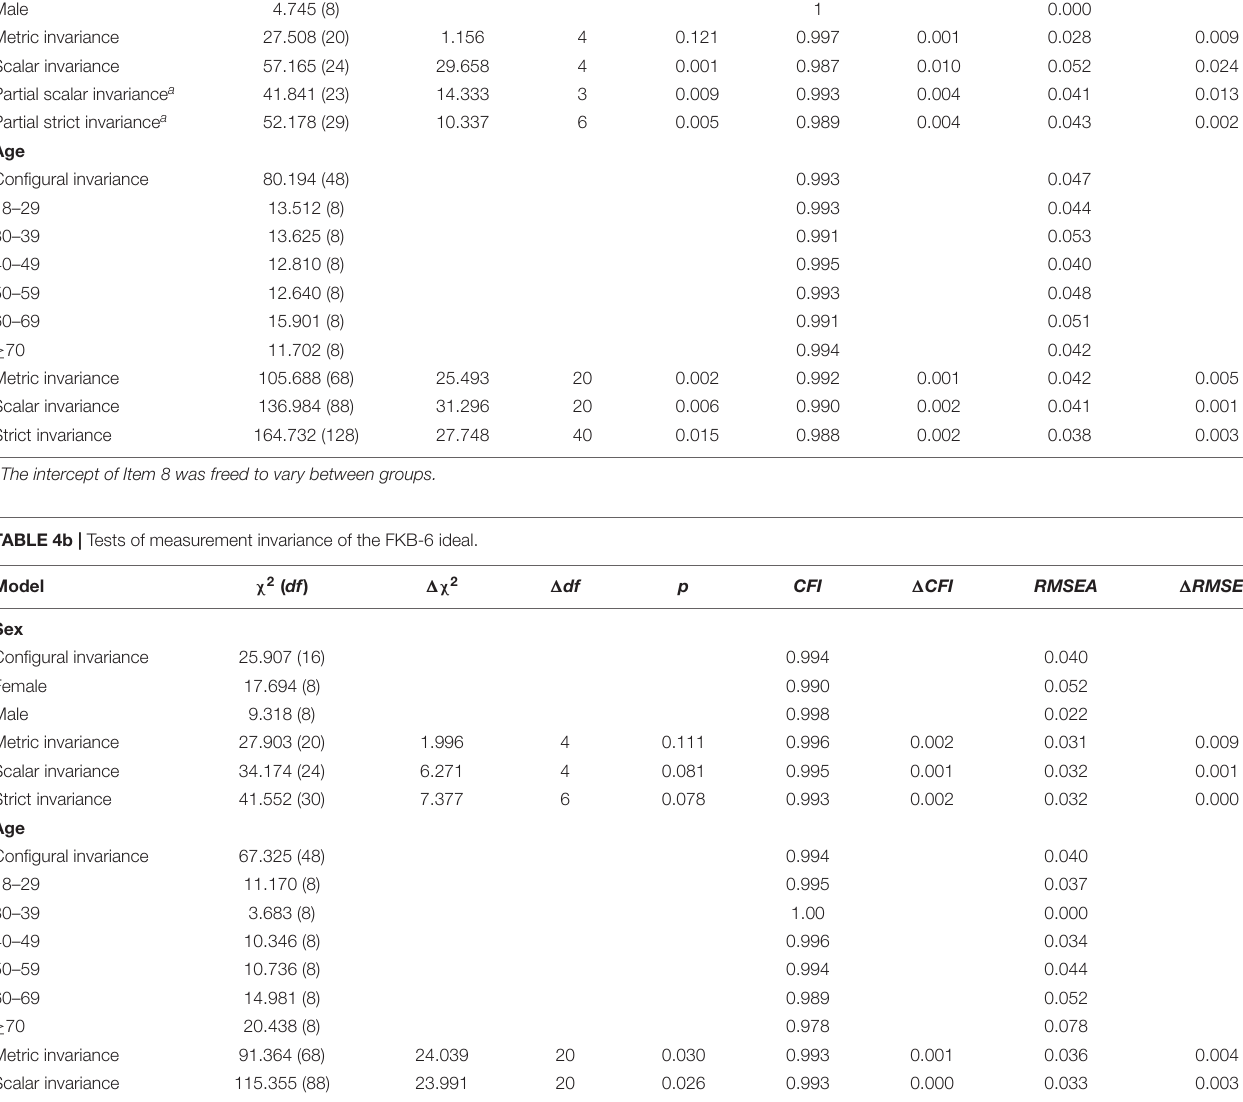
TABLE 4a | Tests of measurement invariance of the FKB-6 real.